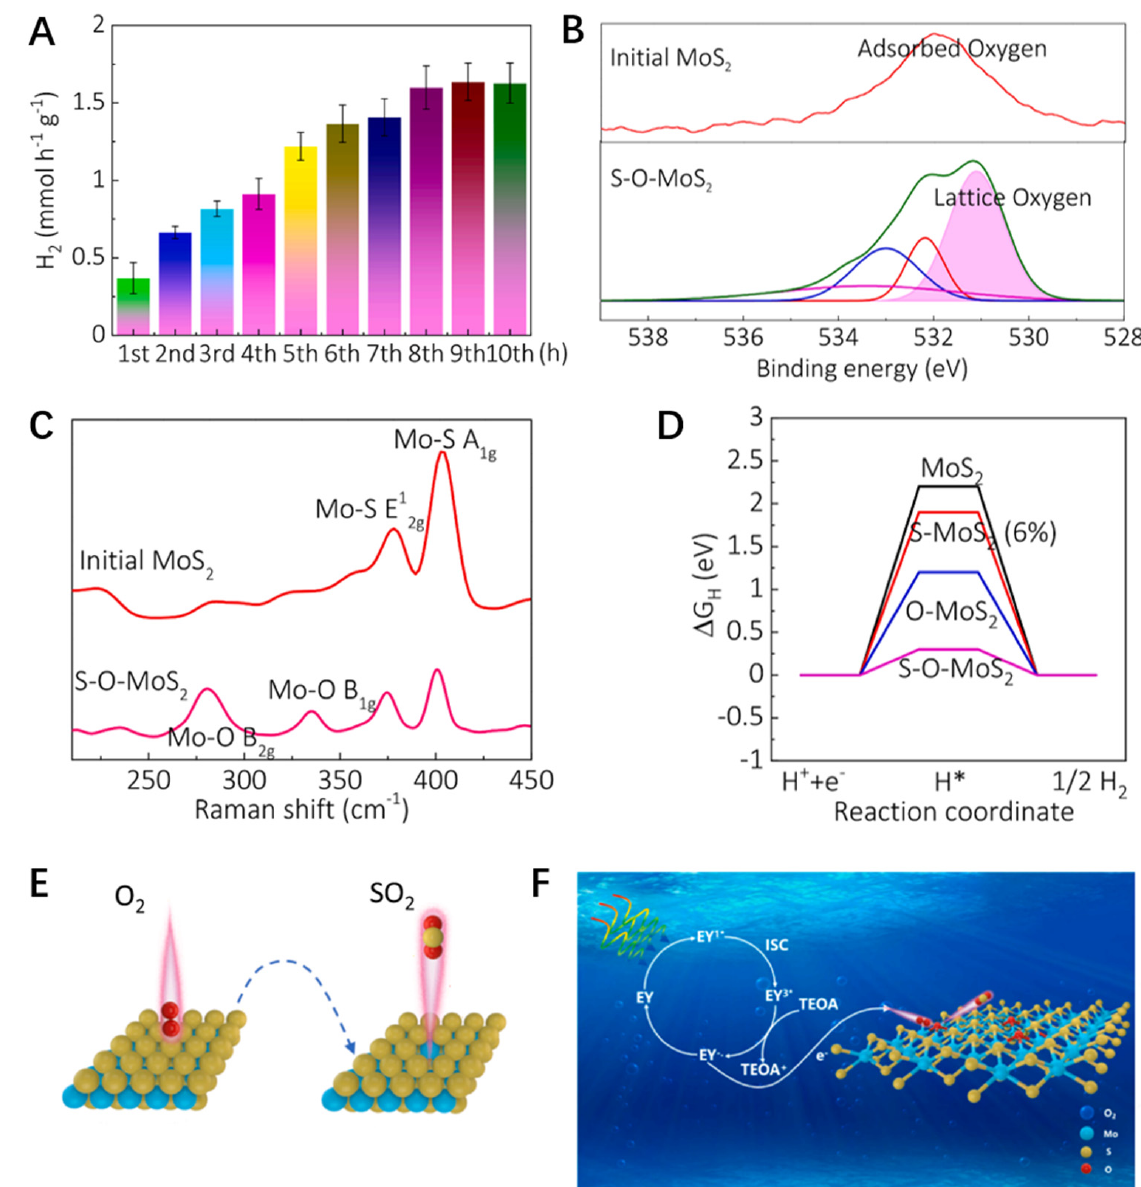
Figure 6. ( A ) Plot of the results of hydrogen production per hour of MoS 2 during the HER detected with an online gas chromatograph every 15 min. ( B ) O 1s high-resolution XPS spectra and ( C ) Raman spectra of pristine MoS 2 and S-O-MoS 2 . ( D ) Hydrogen precipitation ∆ G H* plots of pristine MoS 2 , strained MoS 2 (S-MoS 2 , 6% strain), O-doped MoS 2 (O-MoS 2 , 25 atom% O) and O-doped strained MoS 2 (S-O-MoS 2 , 6% strain, 25 atom% O). ( E ) Schematic diagram of the S vacancy formation process. ( F ) Schematic diagram of the formation mechanism of MoS 2-x O x during the actual reaction. Reproduced with permission [2021], Copyright 2021, Elsevier.